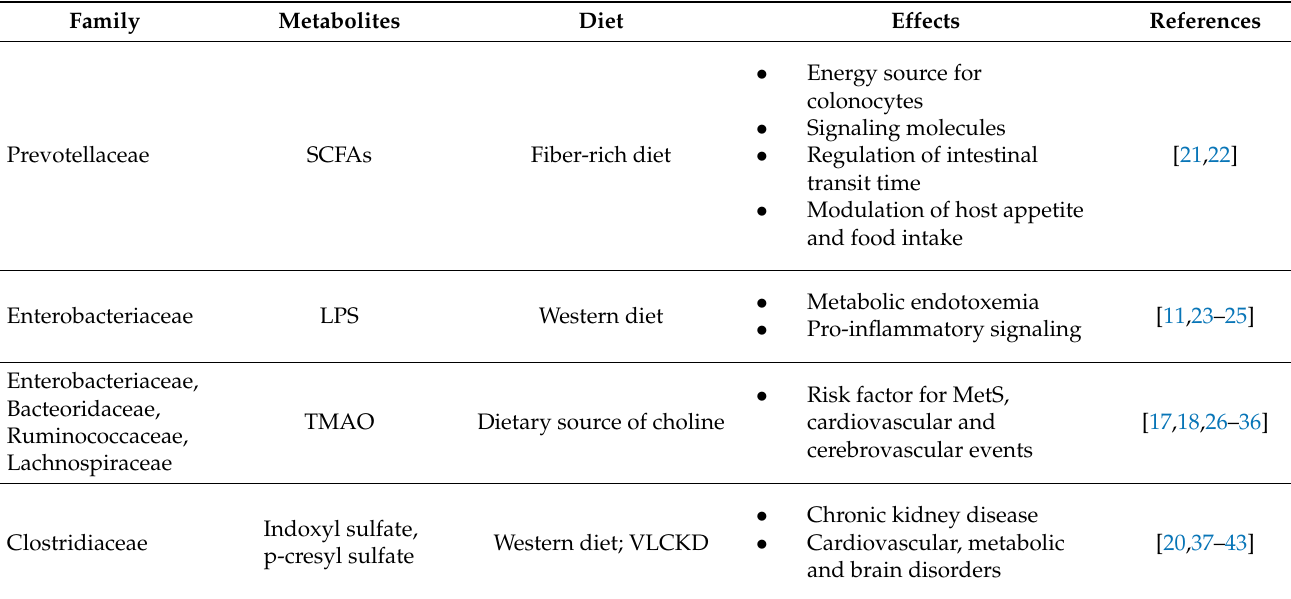
Table 1. Gut microbiota metabolites, diet, and host